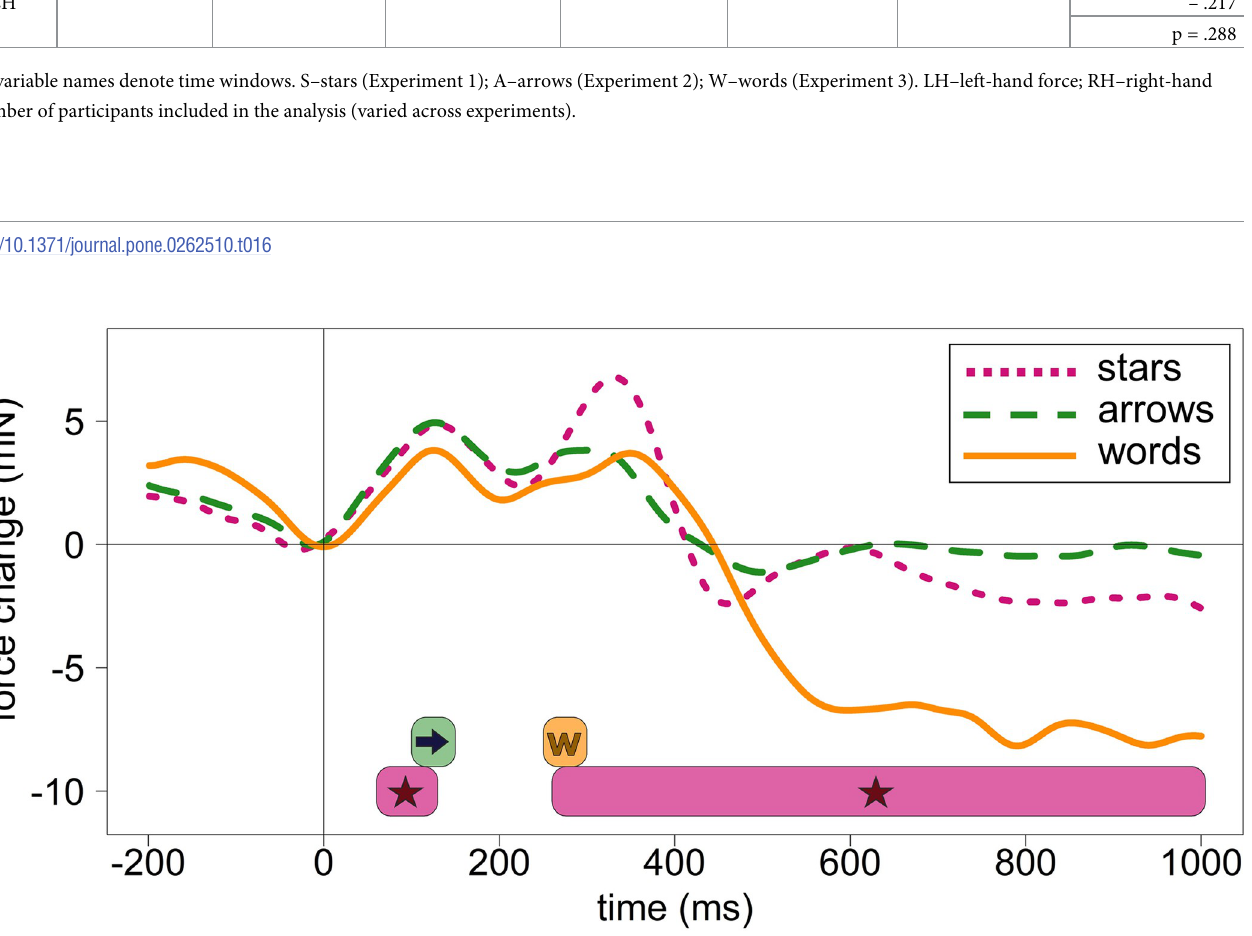
Fig 12. Averaged forces from both hands across all no-go trials (regardless of condition) in three experiments. The dotted pink line represents force modulations caused by the presentation of stars (Experiment 1), dashed green line–arrows (Experiment 2), solid orange line–words (Experiment 3). Colored horizontal bars in the lower part of the graph represent time windows with significant Side X Hand interactions for all three types of stimuli–stars, arrows, and words. The colors of bars correspond to the colors of lines described